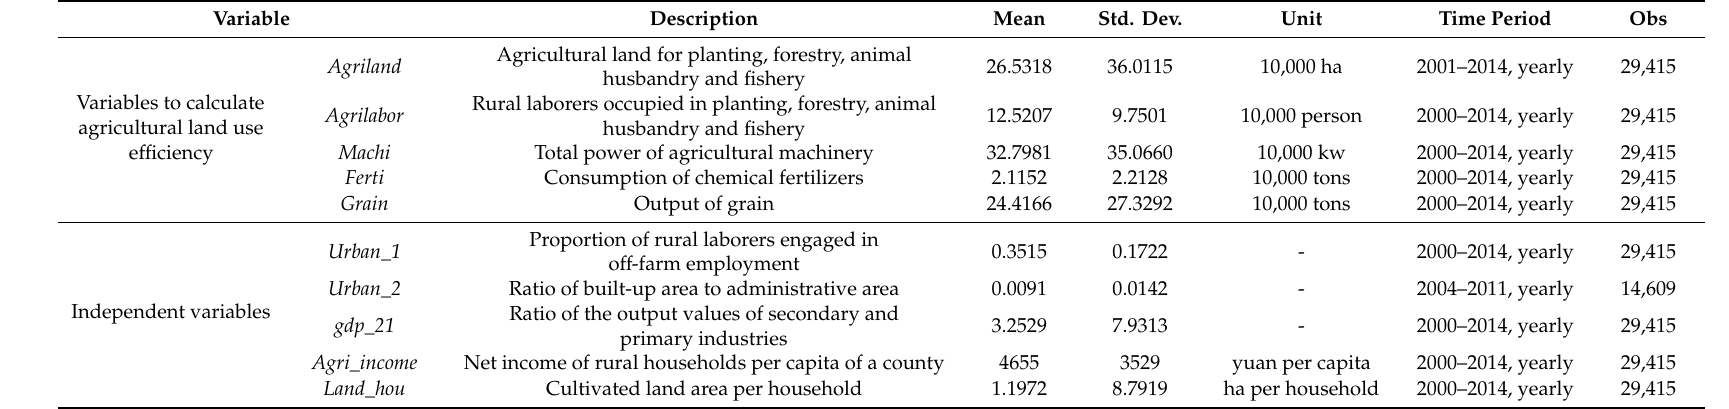
Table 1. Variable definitions and descriptive